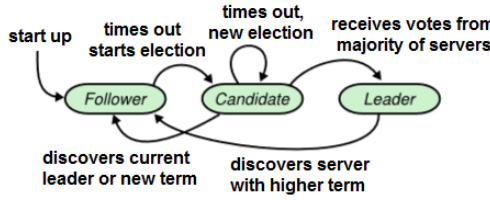
Figure 1. Server states in Raft algorithm